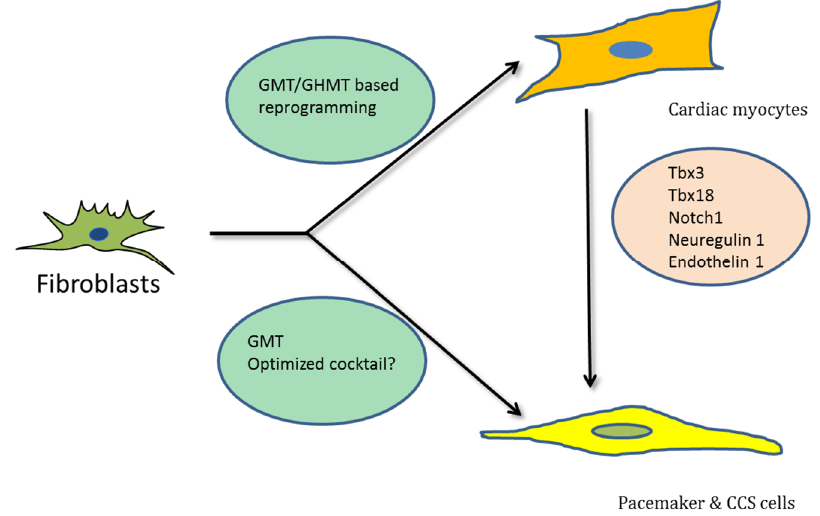
Figure 1. Schematic representation showing transdifferentiation of fibroblasts into different cardiac cell types by various transcription factors, respectively.